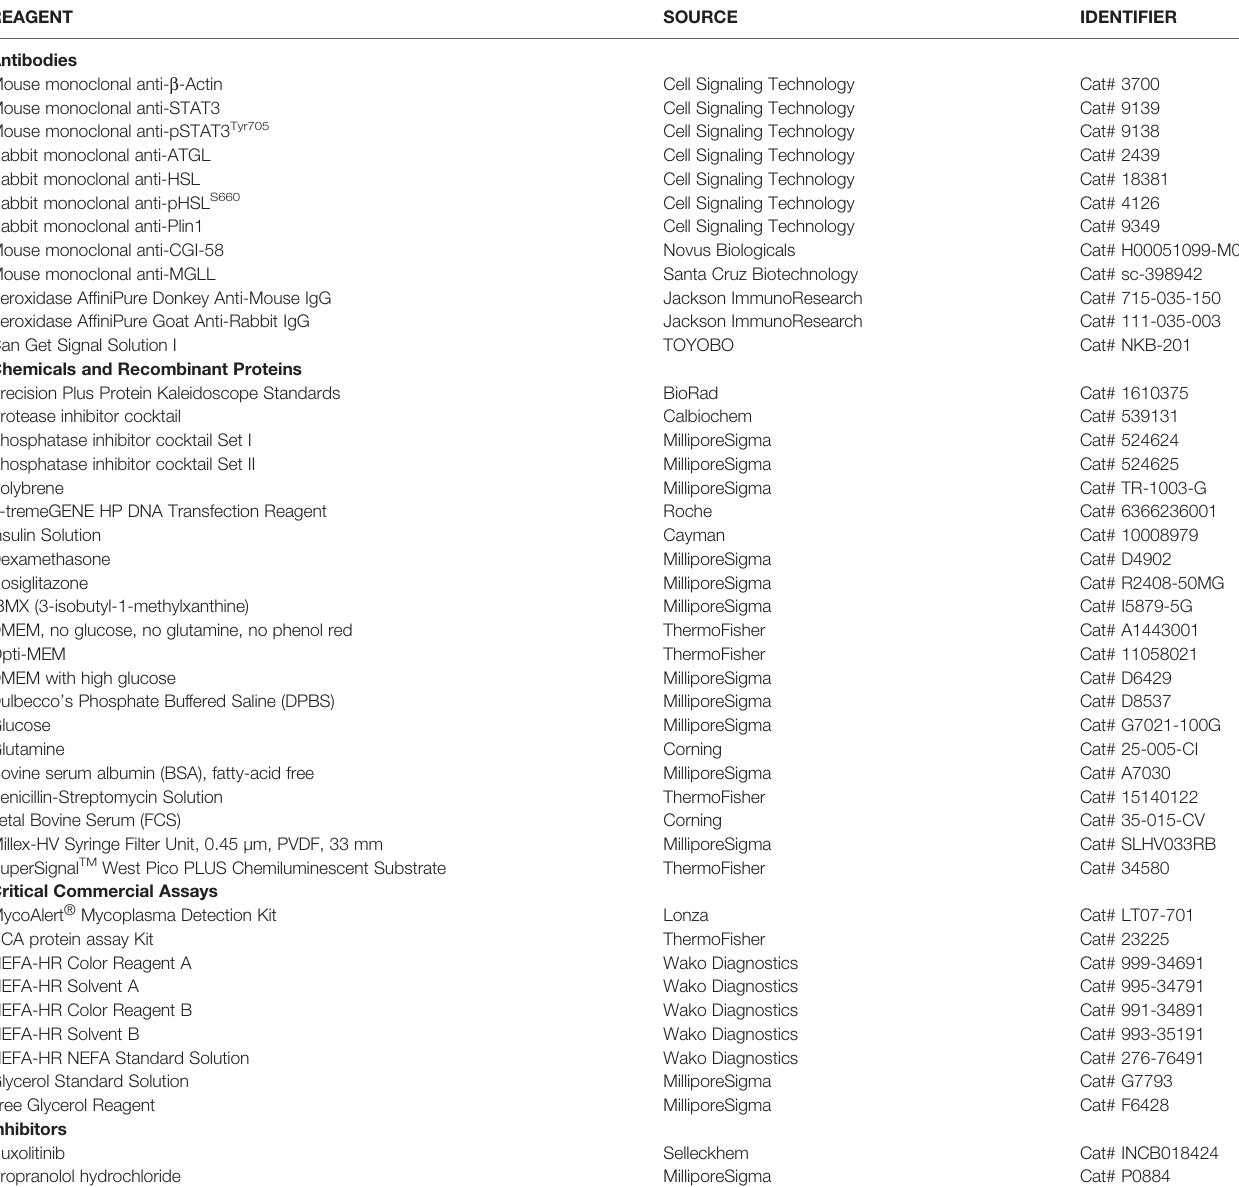
TABLE 1 | Key Resources. REAGENT SOURCE Antibodies Mouse monoclonal anti- b